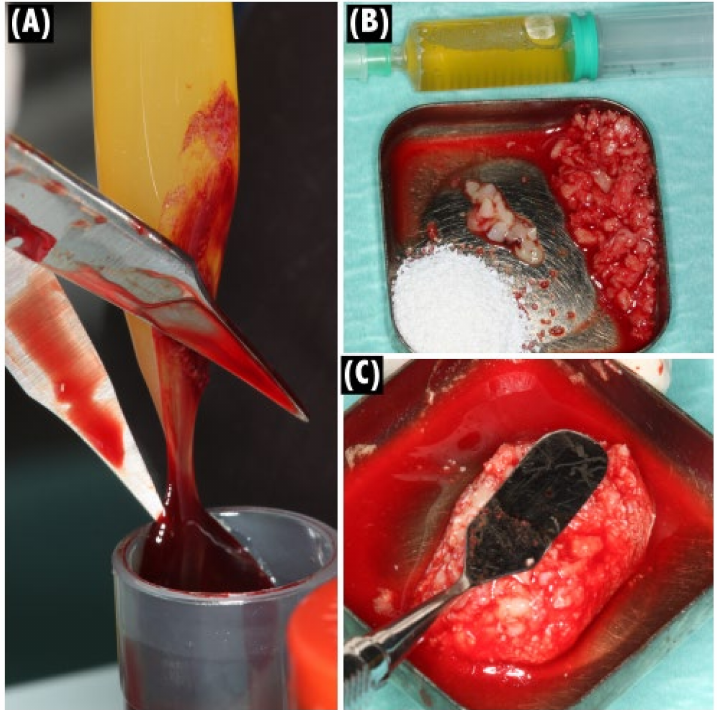
Figure 2. Clinical photographs of the protocol sequence to obtain the composite PRF/particulate xenograft: ( A ) Extraction of the PRF membranes from the red-topped tubes. The membranes were posteriorly pressed in a proper metal box; ( B ) Irrigation of autologous bone and xenograft with liquid fibrinogen obtained from the white-topped tubes; ( C ) Obtaining a composite PRF/particulate xenograft. Note the stiffness of this composite, which acquired a rectangular form.